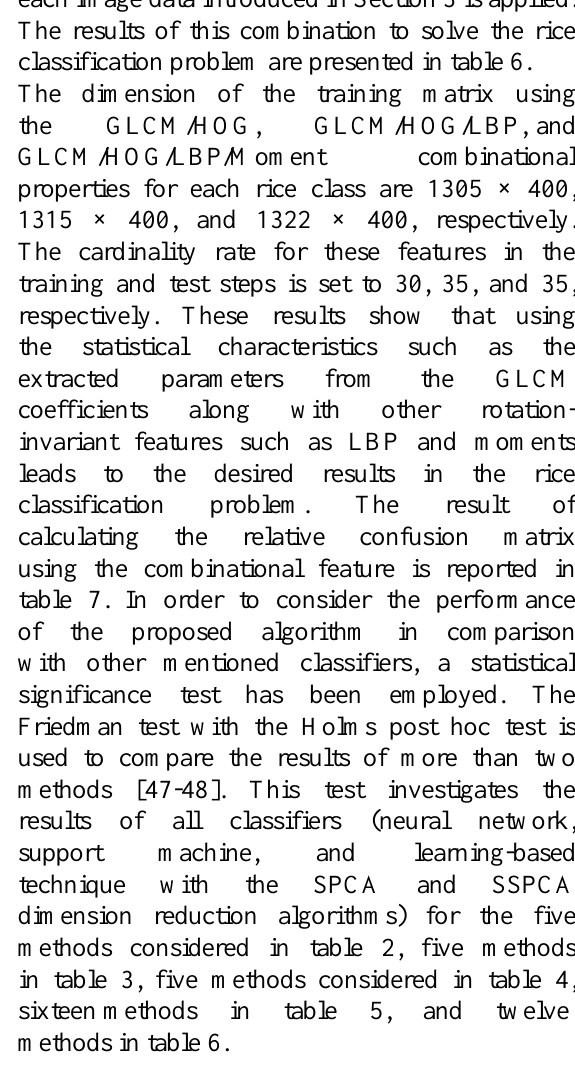
Table 4. Results of the classification rate based on the magnitude and phase of the Gabor coefficients for different classifiers and the proposed learning-based classifier with the SPCA and SSPCA techniques.